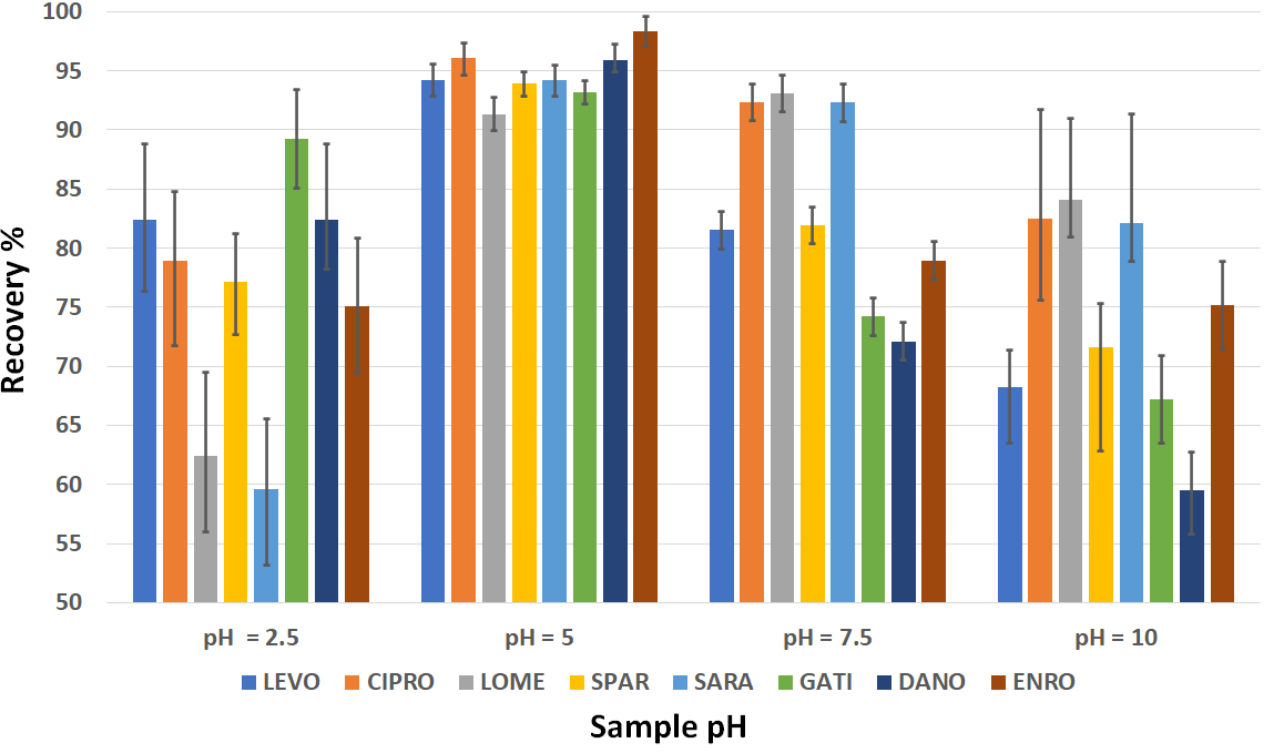
Figure 9. Effect of sample pH ( x -axis) on the recovery ( y -axis) of FLQs.